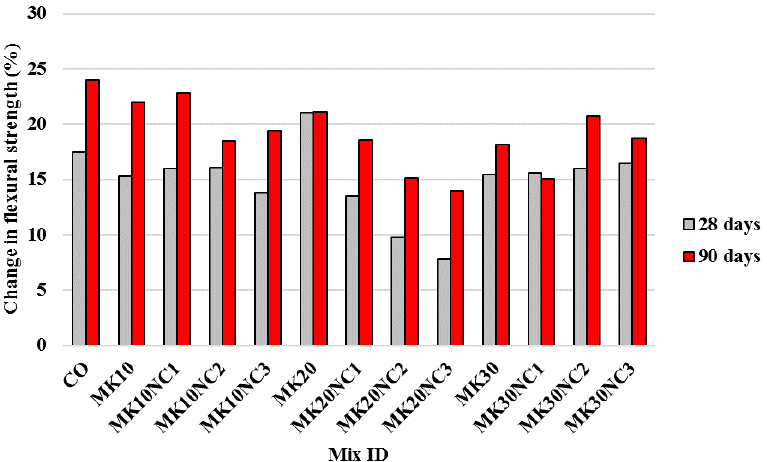
Figure 10. Percentage change in flexural strength of samples by the addition of fibres at 28 and 90 days with similar volumes of MK and NC.